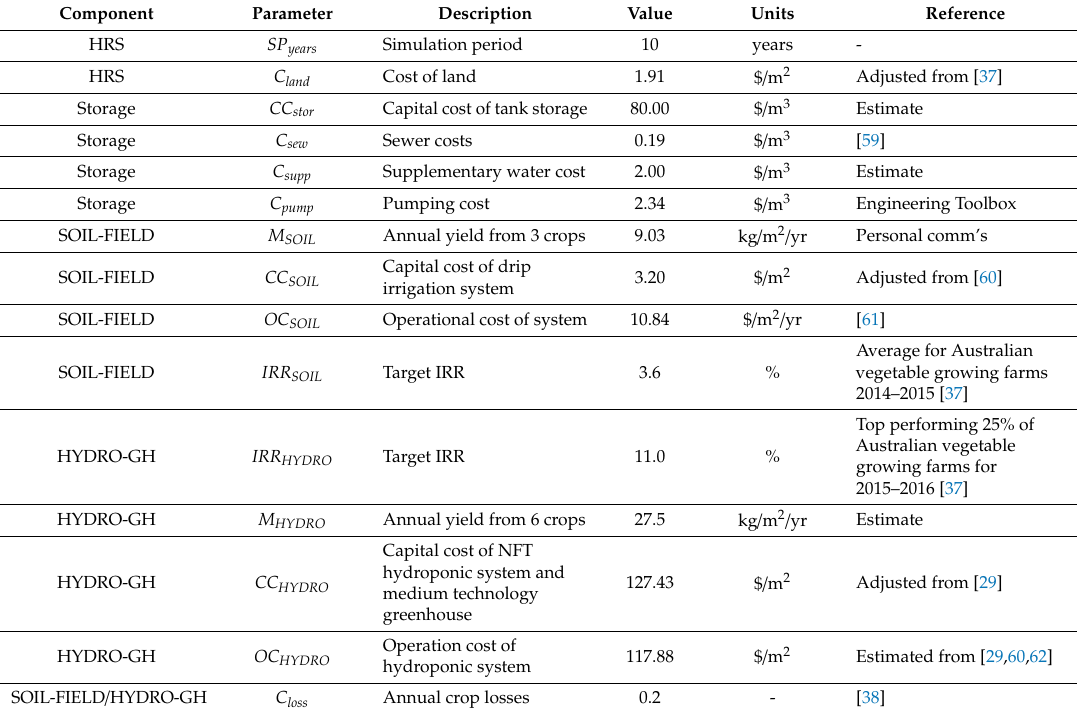
Table A6. Economic model constants (All $ values in